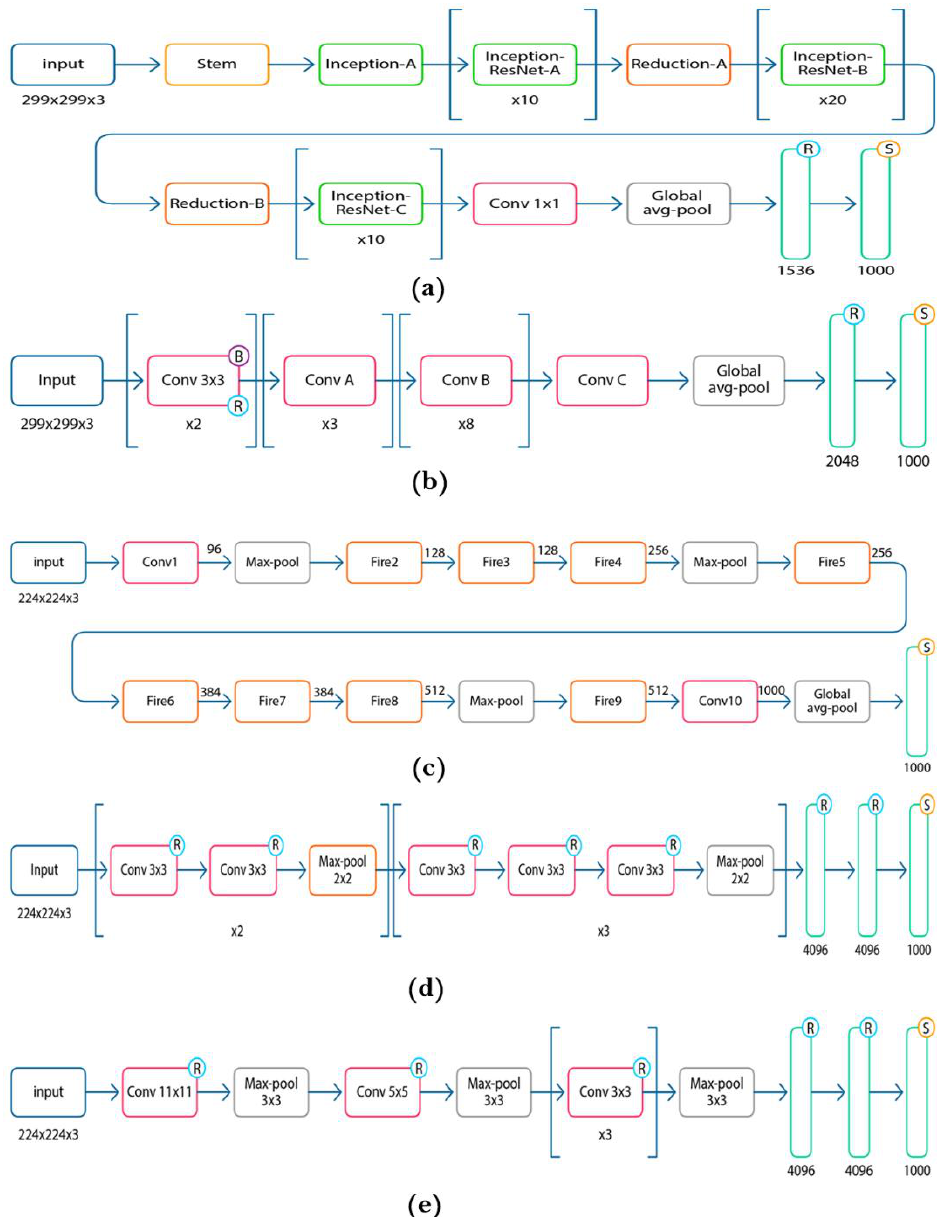
Figure 6. Deep transfer learning models used for detection: ( a ) Inception-ResNetV2 architecture; ( b ) Xception architecture; ( c ) SqueezeNet architecture; ( d ) VGG16 architecture; ( e ) AlexNet ( c ) SqueezeNet architecture; ( d ) VGG16 architecture; ( e ) AlexNet architecture.